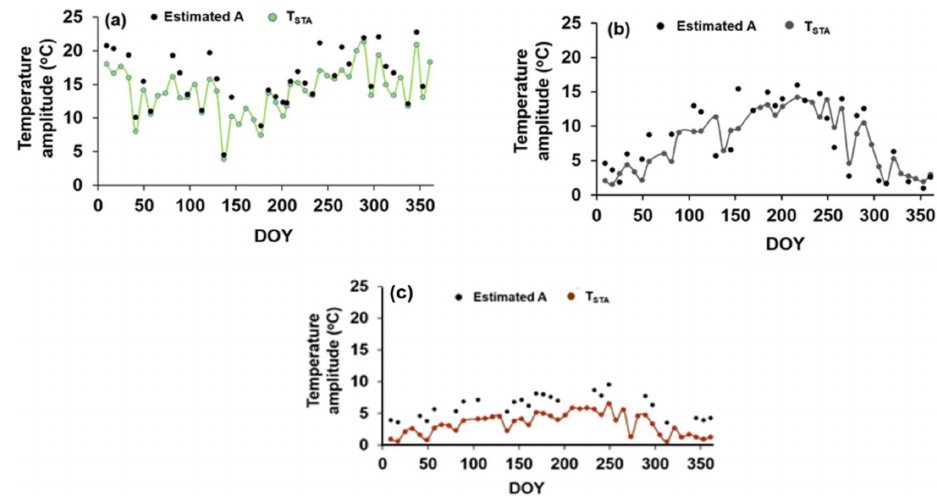
Figure D1. Temporal variation of A and T STA in (a) AU-ASM (2013), (b) US-Ton (2014), and (c) US-Var (2014).